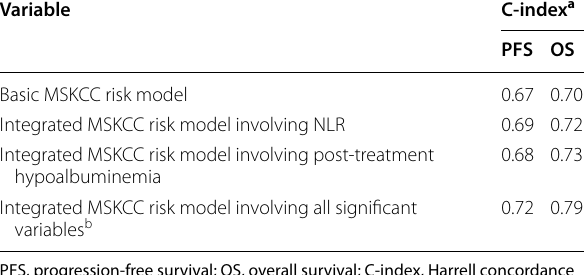
Table 6 Comparison of the survival predictive power of basic MSKCC risk model and integrated model involving post-treatment hypoalbuminemia